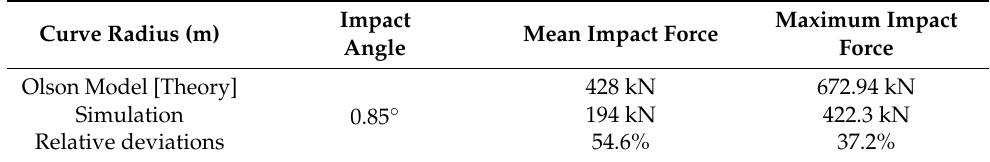
Table 4. Impact force comparison of Olson model and